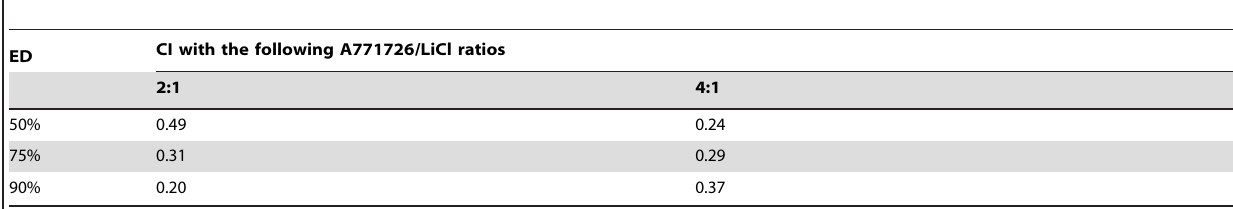
CalcuSyn analysis provides combination index (CI) values to determine potential drug additivity in this Table. Inhibition of EV71 replication was evaluated in CPE test involving treatment with serial dilutions of A771726 (0, 0.625, 1.25, 2.5, 5 and 10 m M) or LiCl (0, 1.25, 2.5, 5, 10, 20 and 40 mM), or with a combination of the 2 compounds at fixed 2:1 or 4:1 ratios. The results show that A771726 combined with LiCl is synergistic, with CI values ranging from 0.20 to 0.49.